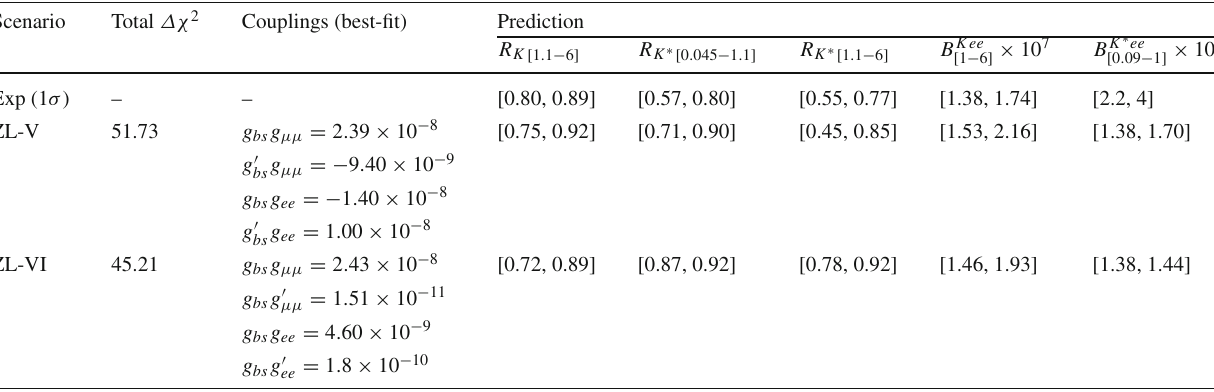
Table 6 Fit results for favoured scenarios in light Z (cid:4) model with couplings both to muons and electrons. Here B Kee ≡ B ( B → Ke + e − ) and B K ∗ ee ≡ B ( B → K ∗ e + e − ) . The experimental values of B Kee and B K ∗ ee are taken from Refs. [63,84], respectively Scenario Total Δχ